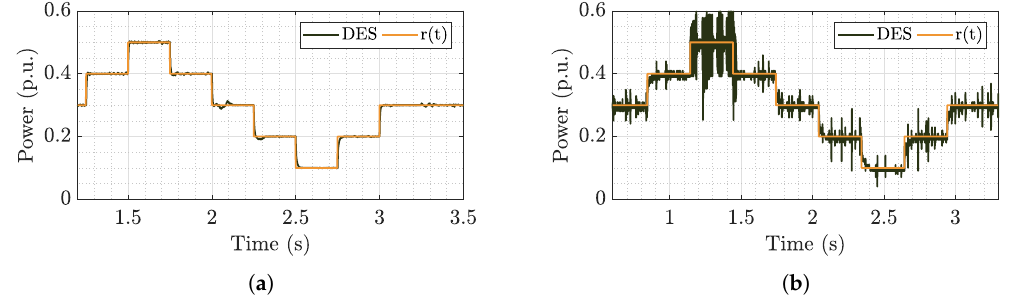
Figure 10. Output power for CPL buck during the ( a ) simulation and ( b )